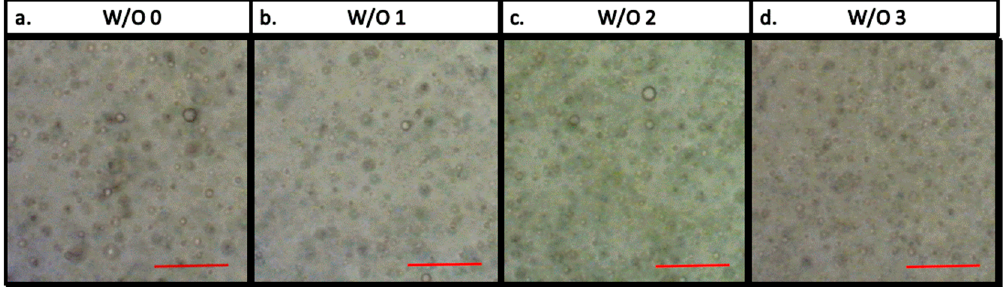
Figure 3. Microphotographs of W/O emulsions stabilized with 1% Span 80 in the presence of different amounts of red wine extract (W/O 0; W/O 1; W/O 2; W/O 3). The length of the red bar on each photograph is 50 µm.